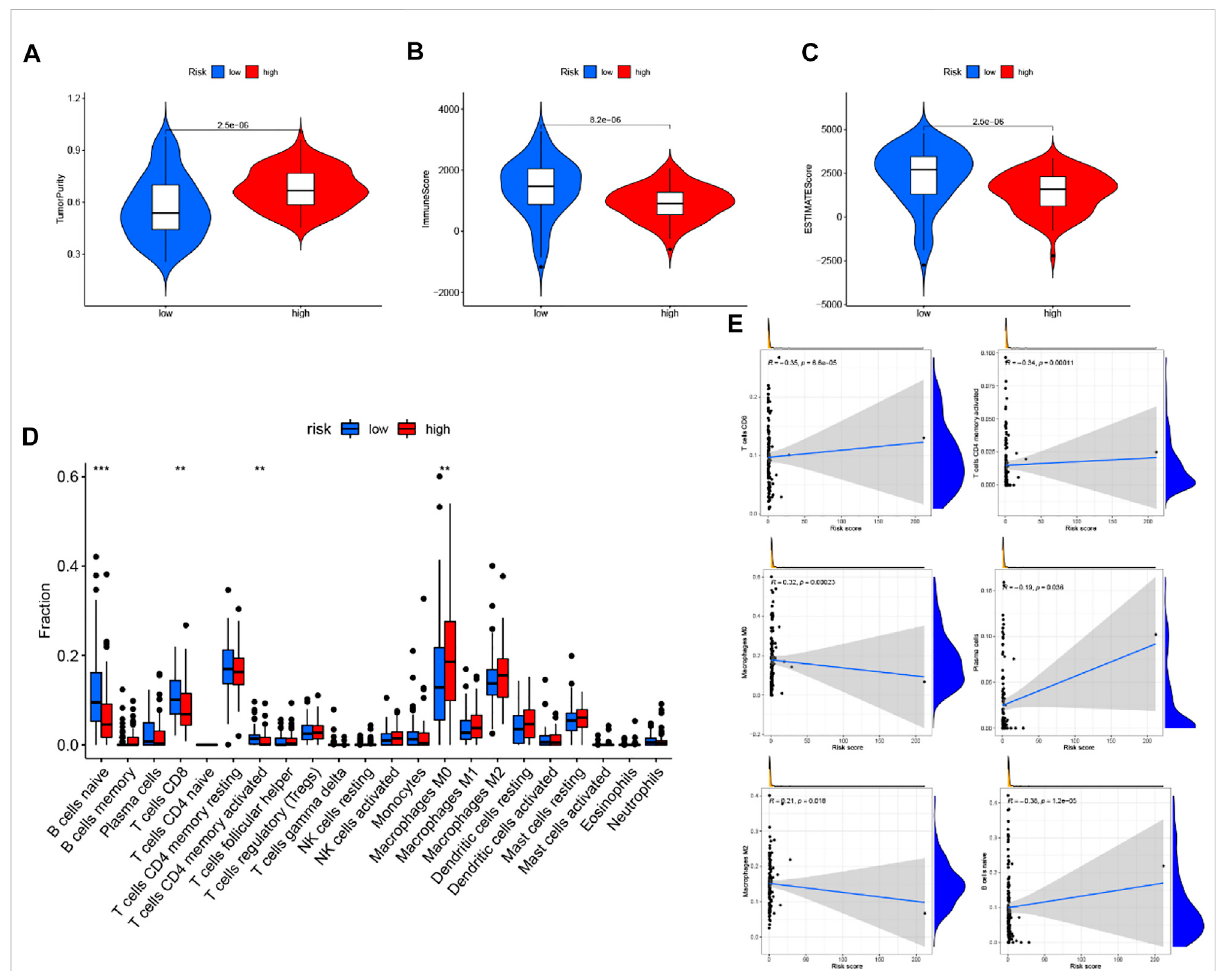
FIGURE 11 Correlation of prognostic risk score with TIME characterization (A – C) The correlation of estimate score, immune score, and tumor purity between these two subtypes. (D) Difference of in fi ltrating immune cell subpopulations and levels between low-/high-risk groups. (E) Correlation between tumor immune in fi ltration and